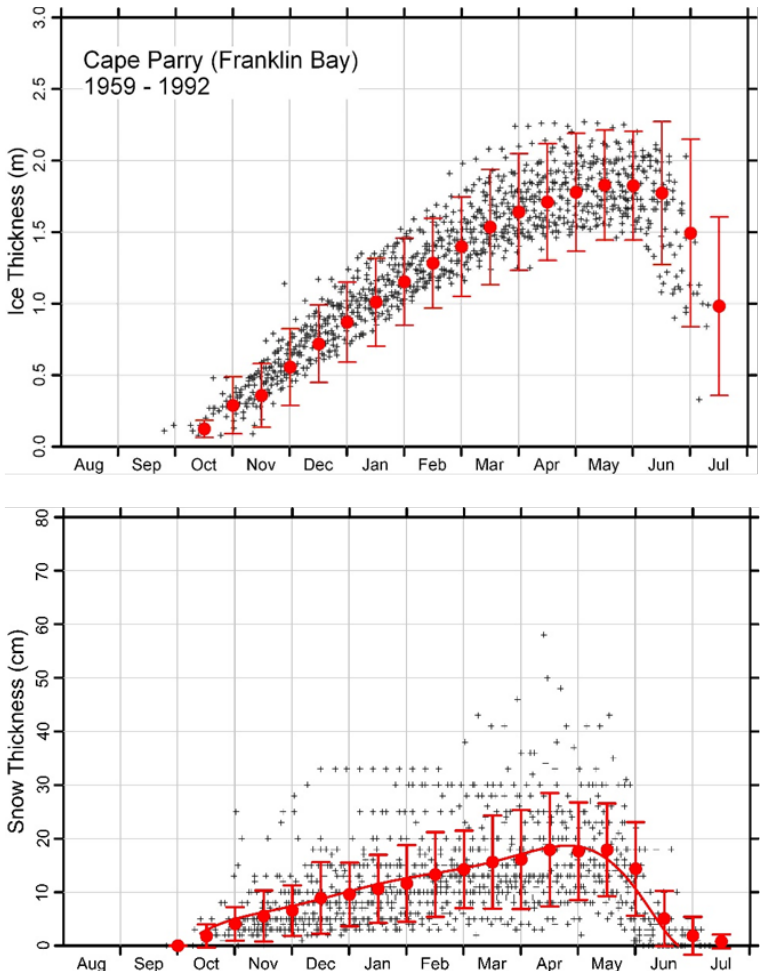
Figure 8. Time series of (a) fact-ice thickness (m) and (b) snow thickness (cm) collected from 1959–1992 by the Meteorological Survey of Canada at a North Warning System station located at Cape Parry. Figure provided by H.